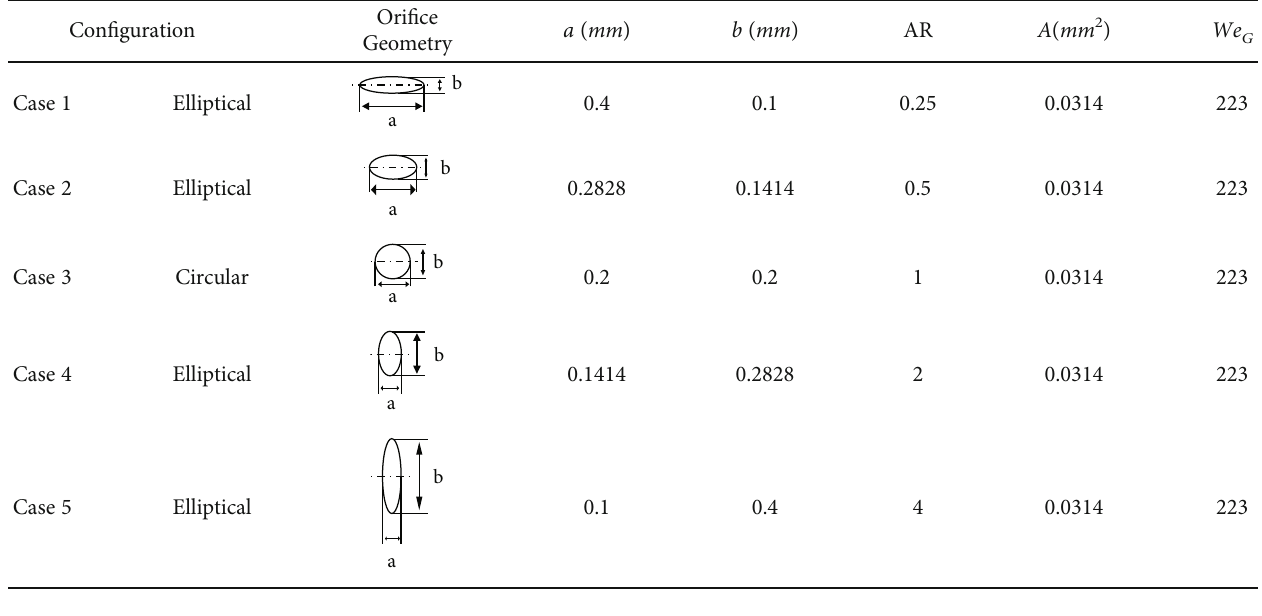
Table 3: Minimum mesh size under three kinds of meshes.